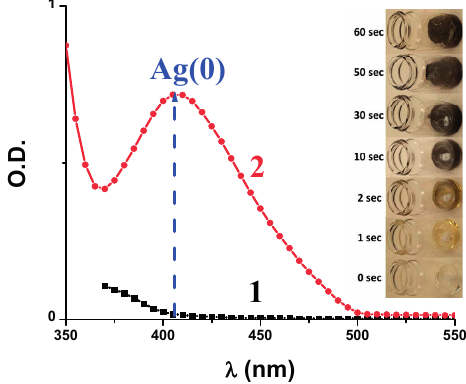
Figure 6. UV-visible absorption spectra of a polymerized TMPTA film using AgSbF 6 (1% w/w ) and NVK (2% w/w ) in the absence ( 1 ) and in the presence ( 2 ) of DPSi (2% w/w ); Insert: Evolution of Ag(0)NPs colors during the synthesis in TMPTA at RT and under